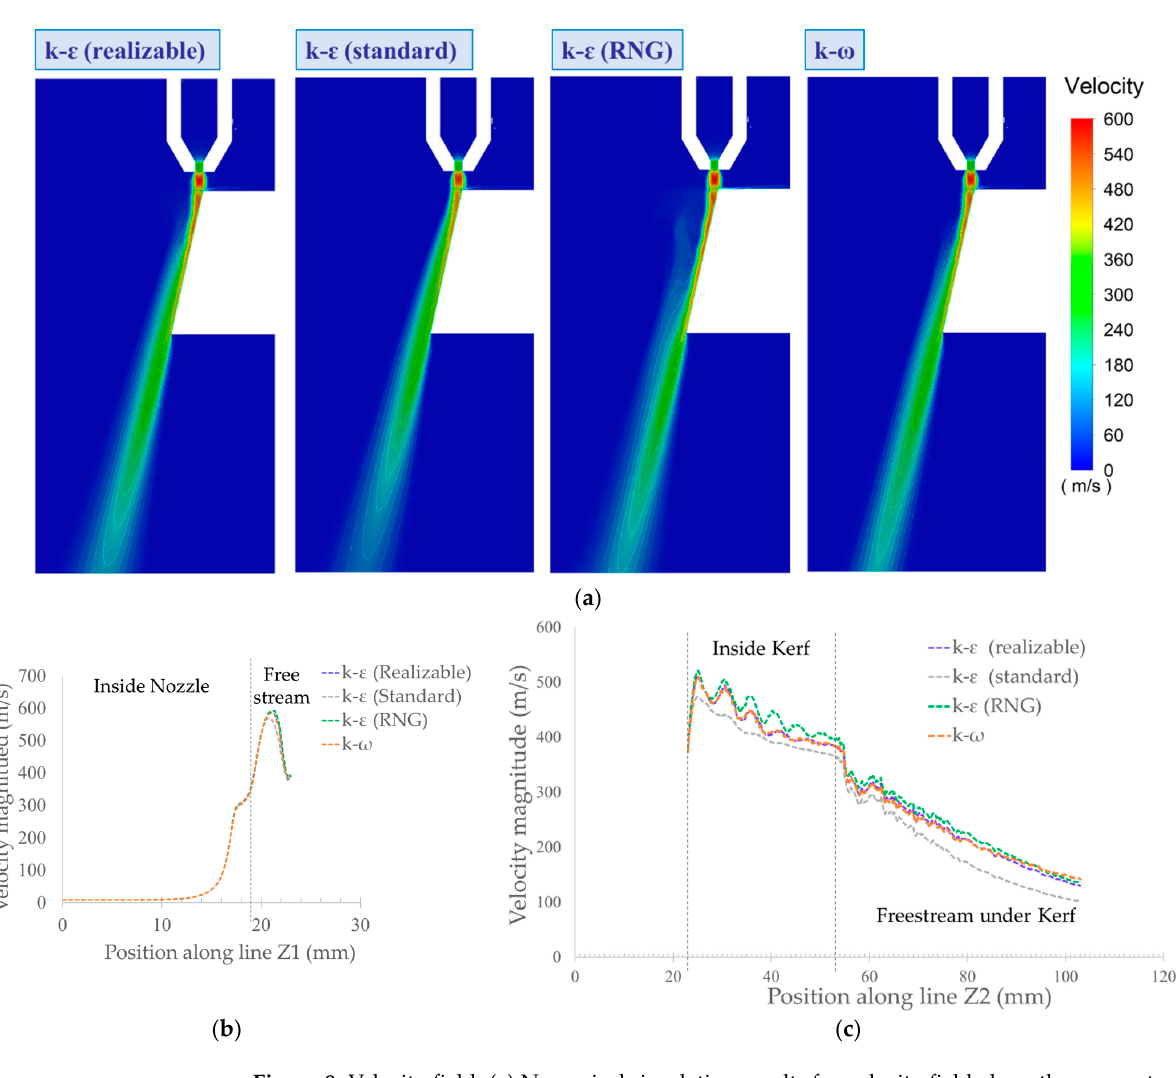
Figure 8. Velocity field. ( a ) Numerical simulation results for velocity field along the symmetry plane for four turbulentf models. ( b ) Velocity distribution curve along the line Z1 for four turbulent models. ( c ) Velocity distribution curve along line Z2 for four turbulent models.